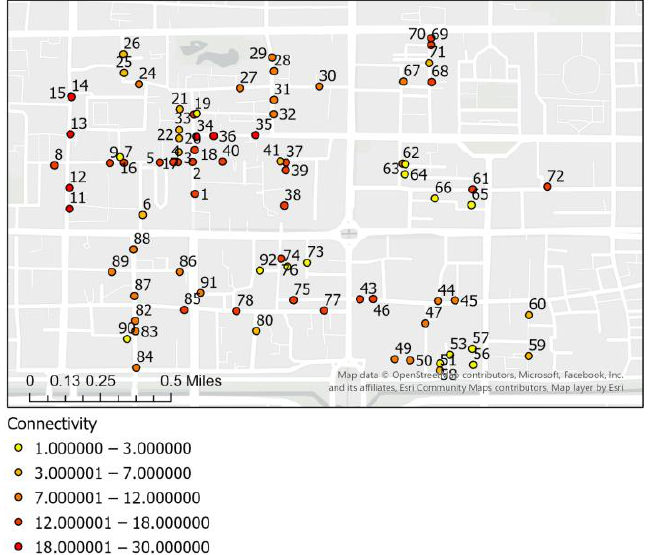
Figure 6. Connectivity of points based on axial map before and after the